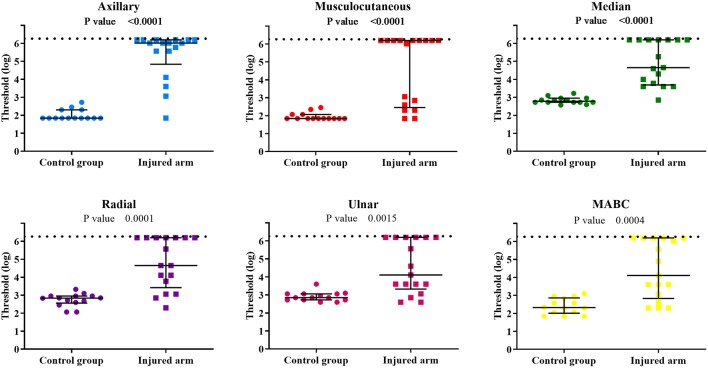
Individual sensory threshold values in the 6 PEIs of the control group compared to the BPI patients' injured upper limb. Lines represent the median values of each group with the interquartile ranges. P-values of the statistical difference between groups (control × injured) are presented in each graph. The broken line represents the top limit of the set of monofilaments used (6.20). ● = control (n = 14) and ■ = BPI patients (n = 17).